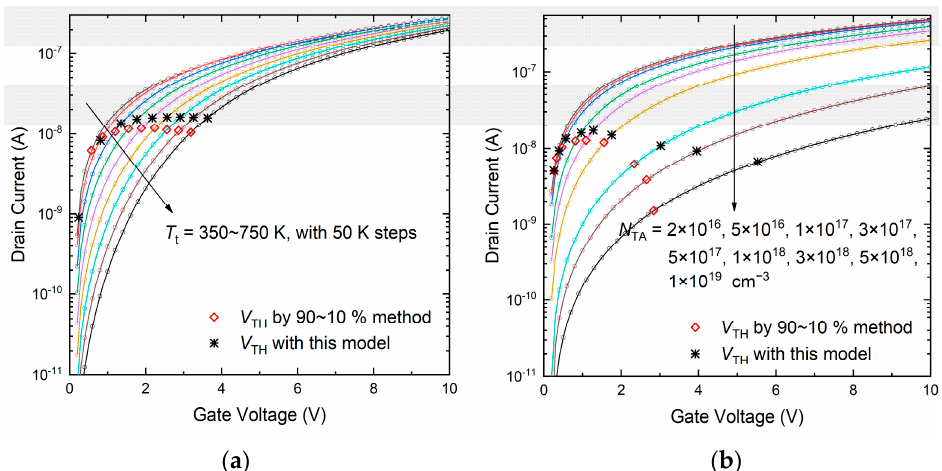
Figure 3. Transfer characteristics ( V DS = 0.1 V) under various tail states ( a ) T t ( N TA = 1 × 10 18 cm − 3 ) and ( b ) N TA ( T = 500 K), with extracted V TH marked in the figures.